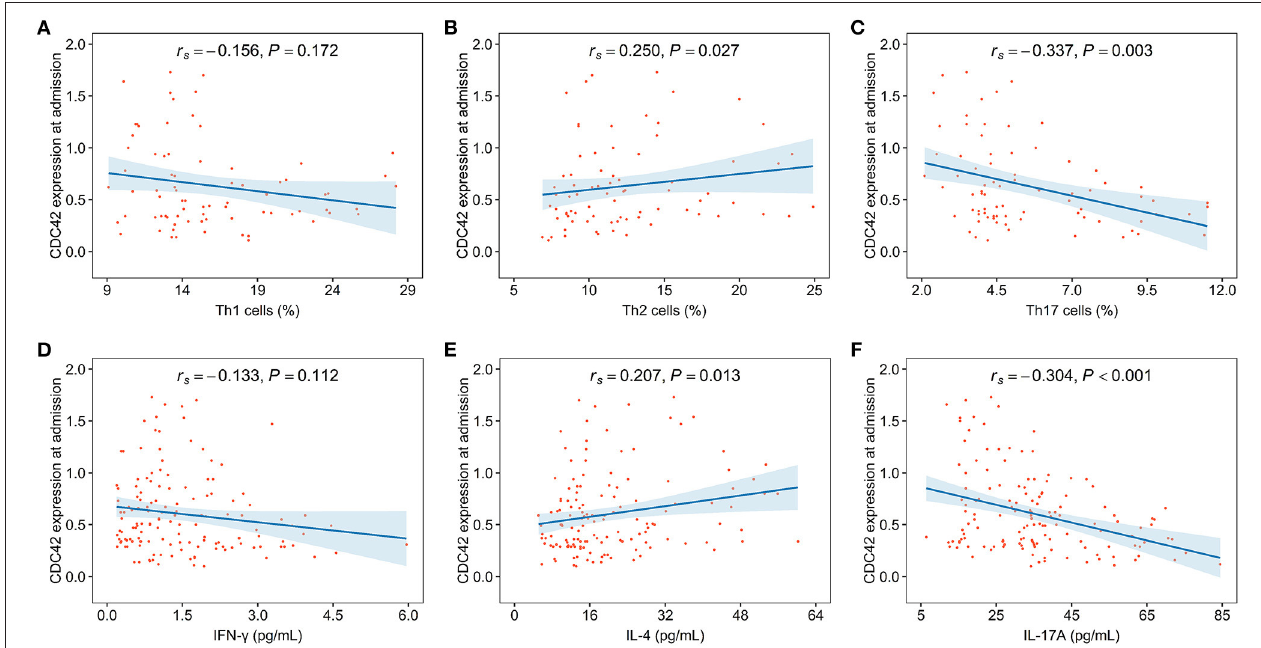
FIGURE 4 | CDC42 was associated with T helper (Th)2, Th17 cells, and their secreted cytokines in patients with AIS. The correlation of CDC42 with Th1 cells (A) , Th2 cells (B) , Th17 cells (C) , interferon-gamma (IFN- γ ) (D) , interleukin-4 (IL-4) (E) , and interleukin-17A (IL-17A) (F) in patients with